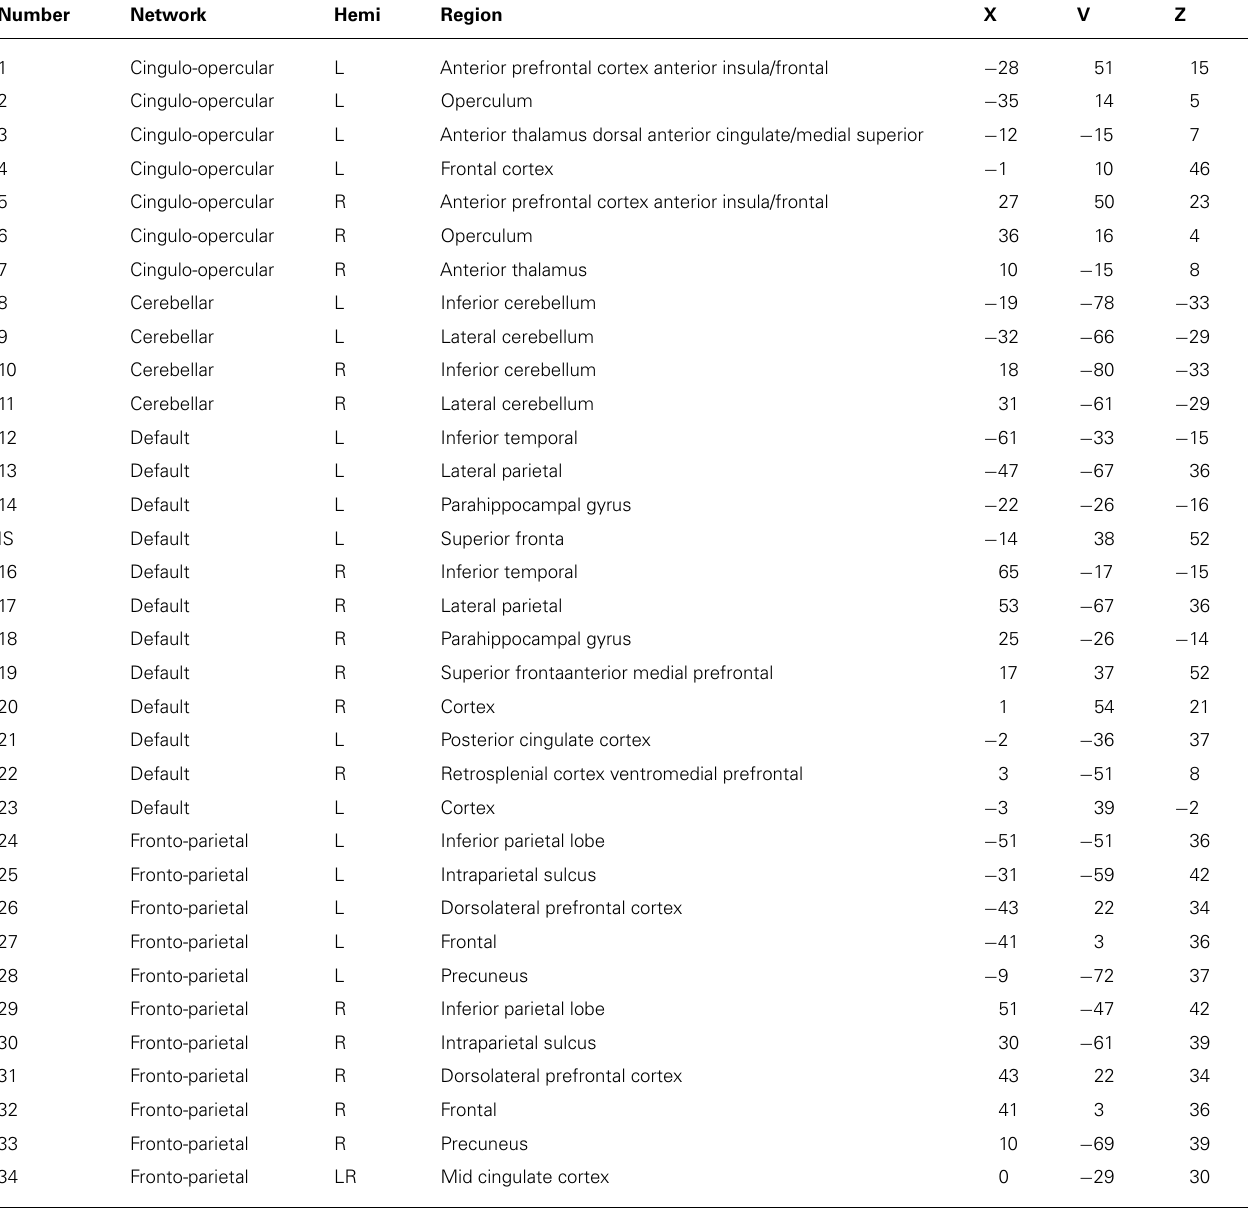
Table 2 | Seed regions of